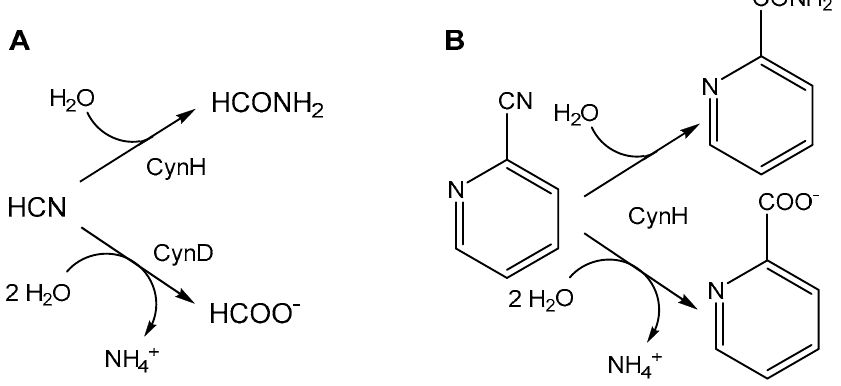
Figure 1. Transformation of ( A ) HCN by cyanide hydratase (CynH) or cyanide dihydratase (CynD), and ( B ) transformation of 2-cyanopyridine by CynH.